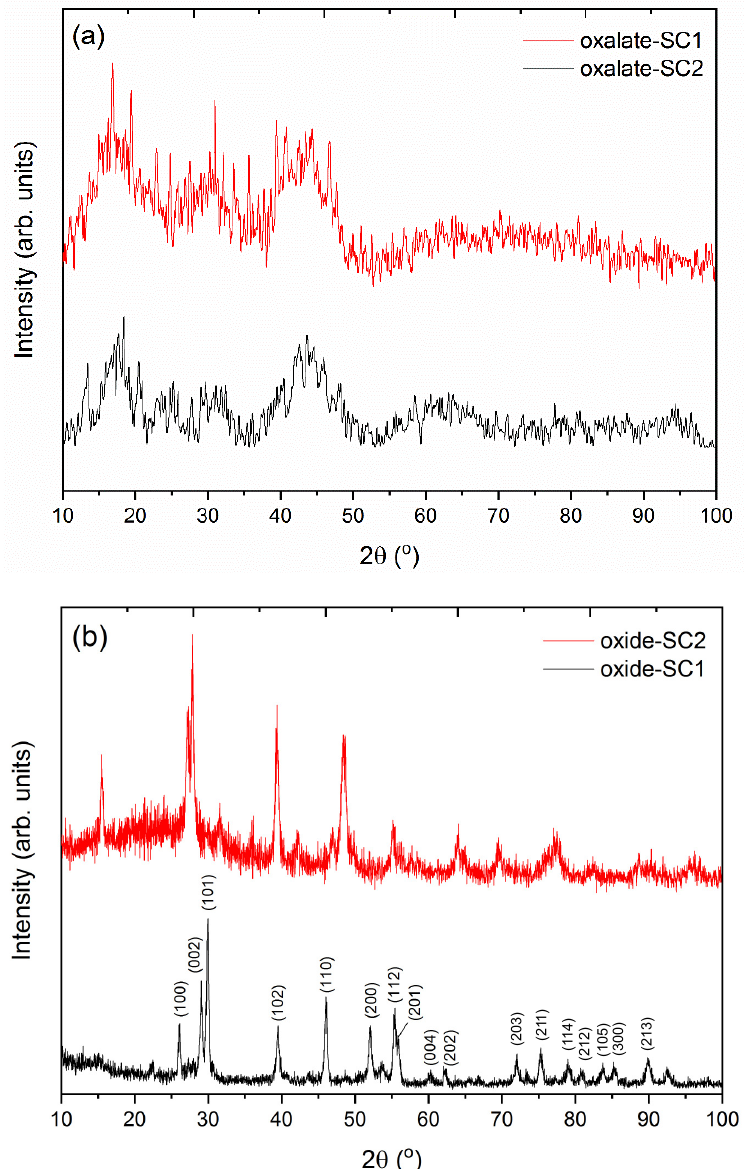
Figure 7. XRD patterns of ( a ) the stripped precursor solids and ( b ) after the subsequent thermal treatment.